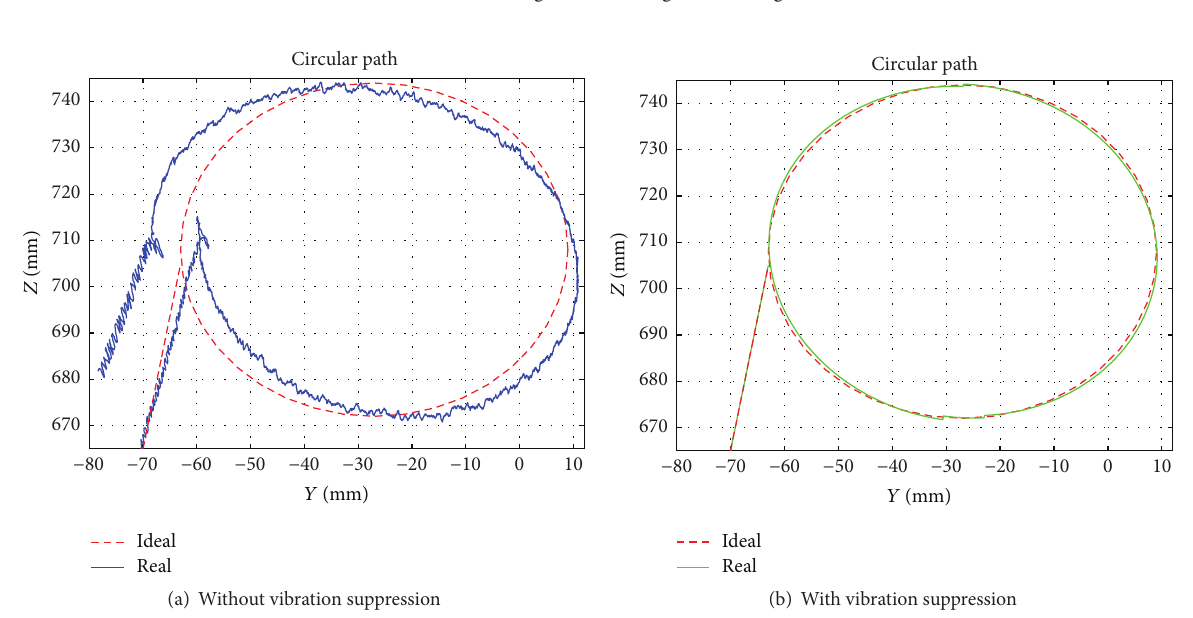
Figure 11: Tracking of the rectangular welding task.